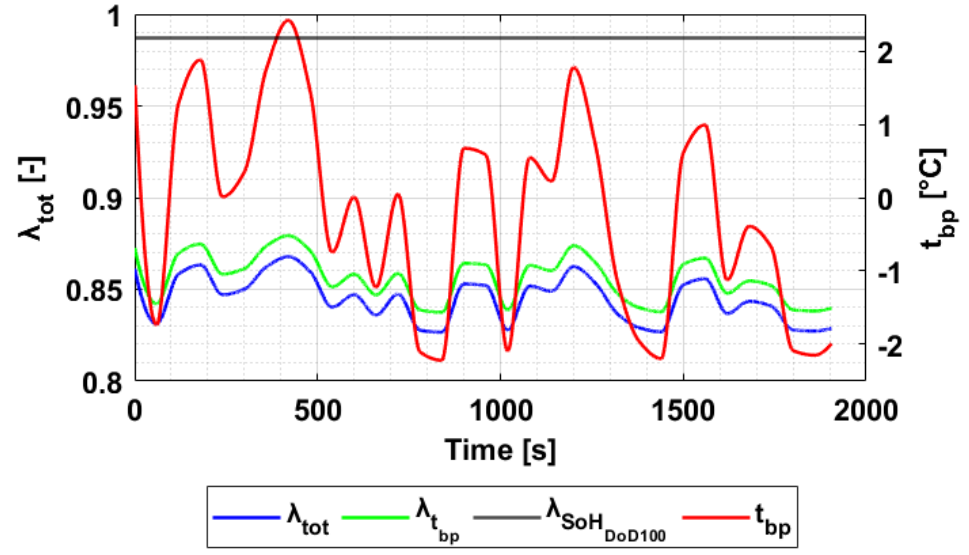
Figure 19. Combined effect of the battery pack temperature and the battery ageing level on λ tot for DM25 in the case of a battery with 200 life-cycles completed and DoD100.